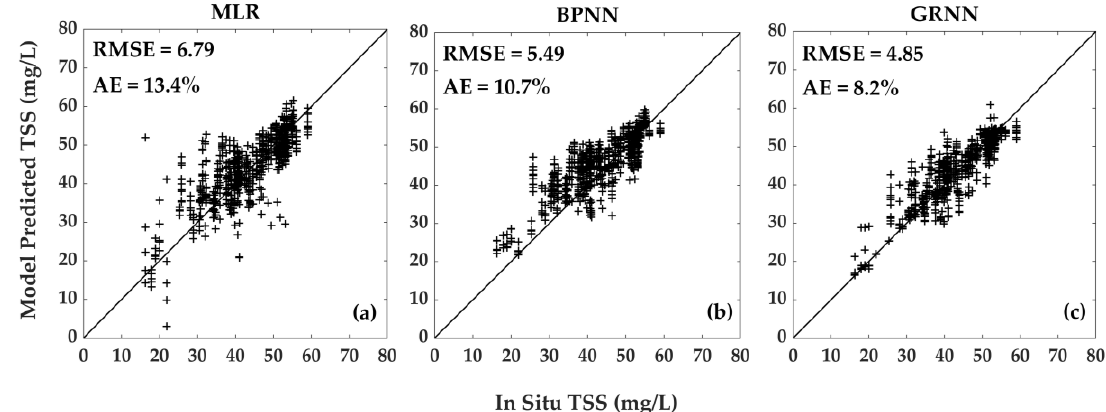
Figure 3. Accuracy evaluation of multi-parameters forecasting models for sunny-day TSS based on ( a ) MLR, ( b ) BPNN, and ( c ) GRNN.